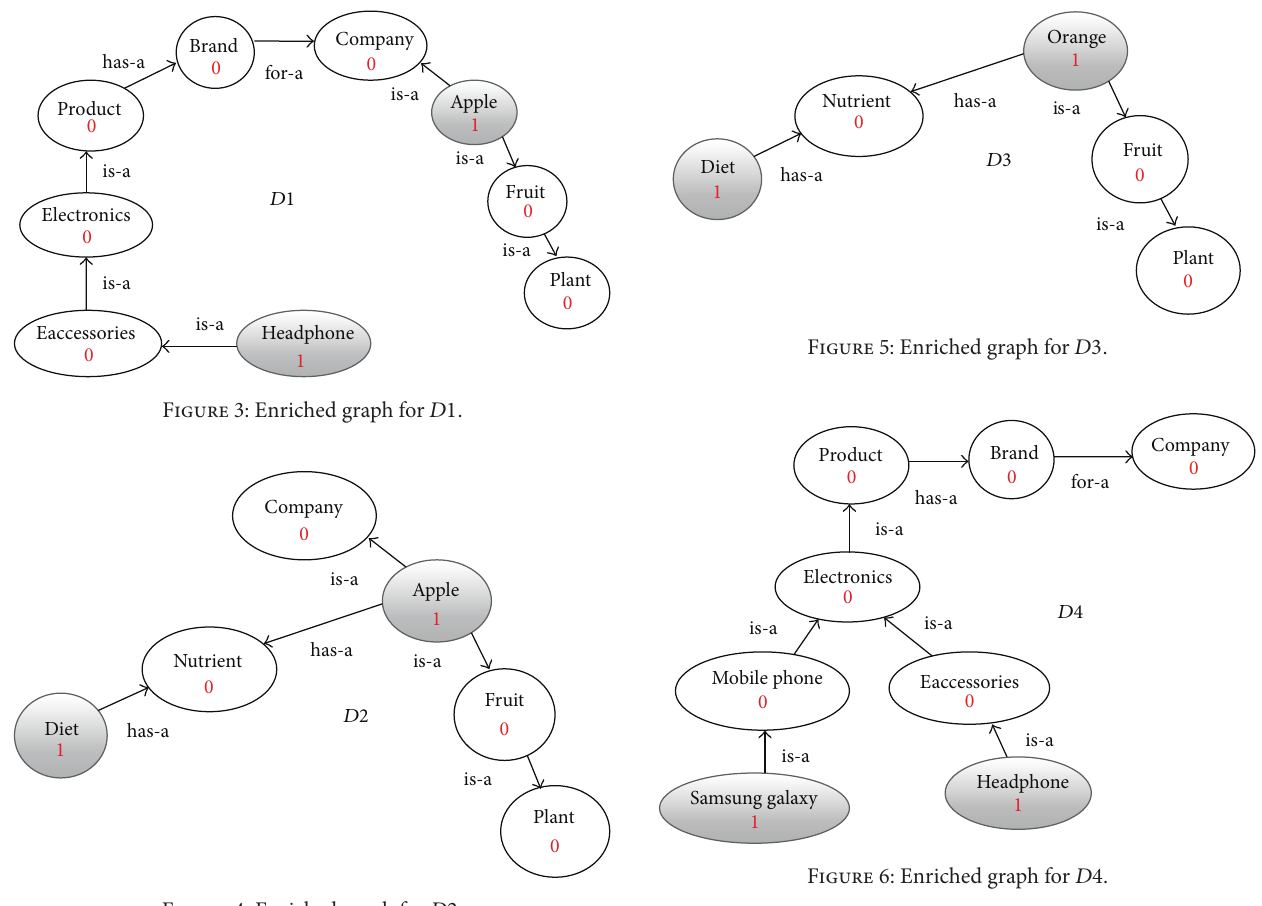
Figure 4: Enriched graph for 𝐷2 .